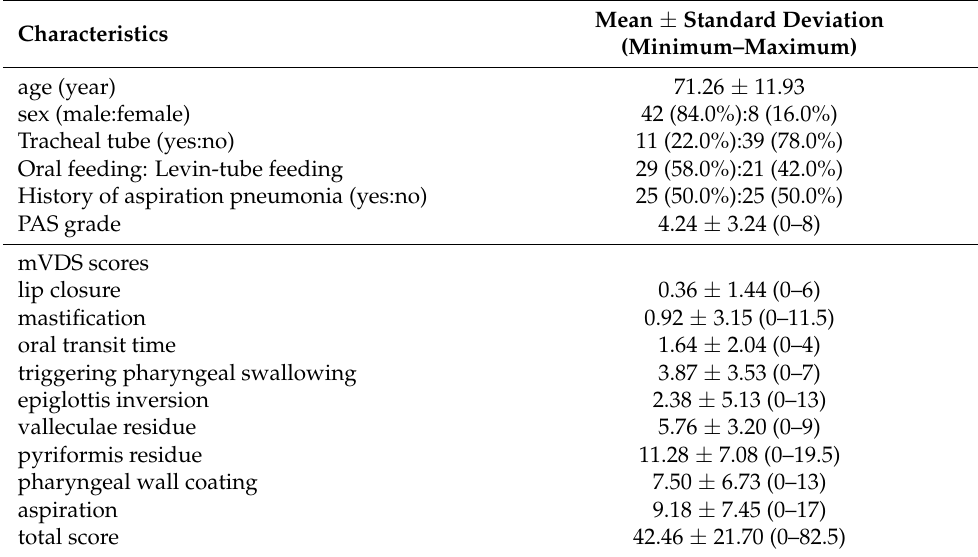
Table 2. Characteristics of patients with dysphagia due to deconditioning or frailty in the present study.